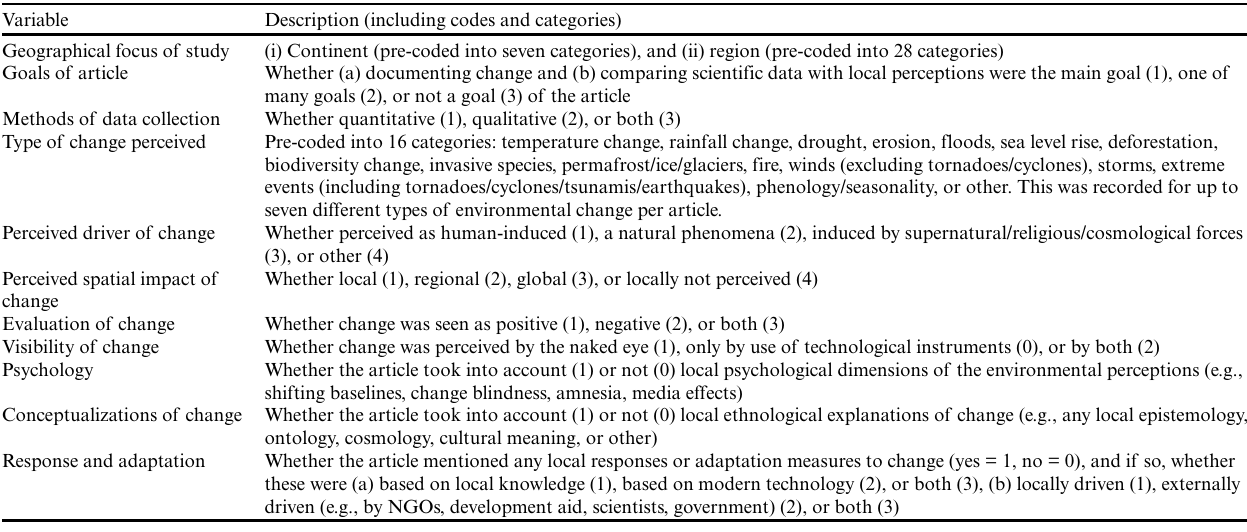
Table 1 . Variables for which data were collected, with scales and categories of analysis.